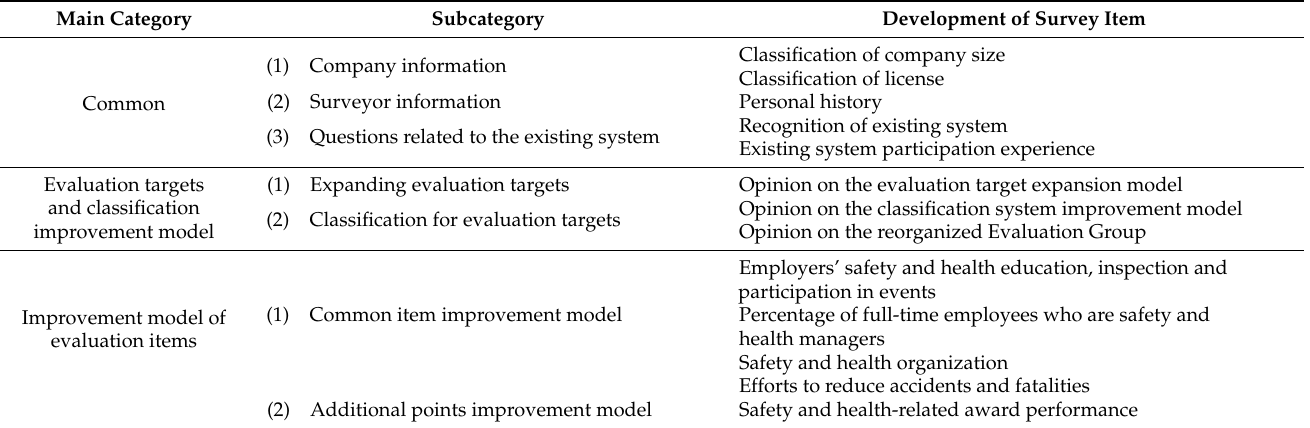
Table 16. Survey items by